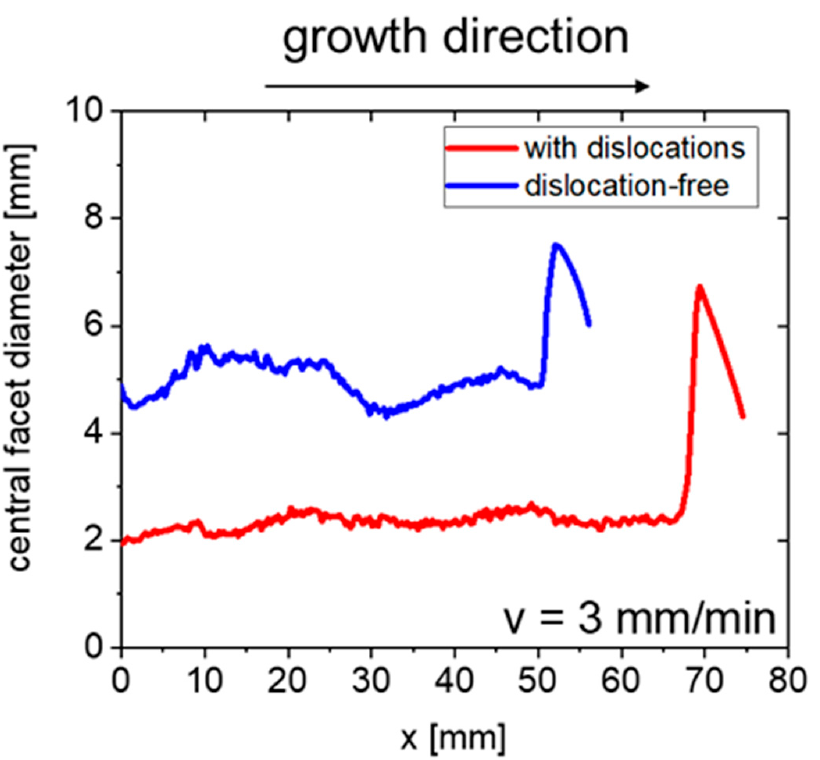
Figure 8. Diameter of the central facet along the growth direction for two <111>-oriented silicon crystals grown at a translation rate of V = 3 mm/min. One crystal was essentially dislocation-free (blue curve); in the other crystal, dislocation were present (red curve).